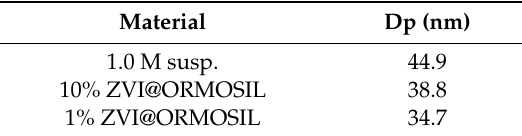
Table 2. Average crystallite